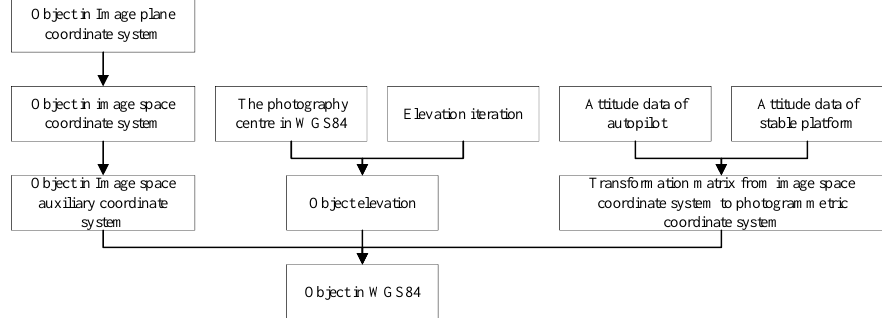
Figure 7. Positioning process from image point to object